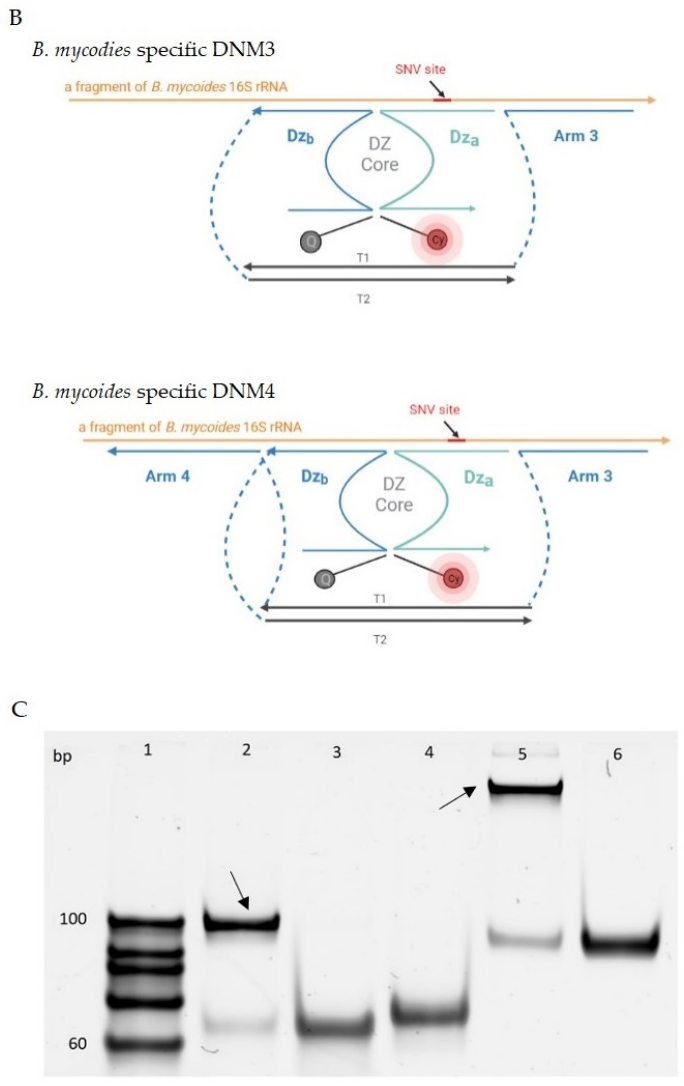
Figure 2. Design of DNM3 and DNM4 used in the study. ( A ) Design of B. thuringiensis –specific DNM3 and DNM4. DNM3 has a separate arm (Dz a ) and two arms (Dz a and Arm 3) attached to the dsDNA scaffold (T1 and T2). DNM4 has a separate arm (Dz a ) and three arms (Dz a , Arm 3 and Arm 4) attached to the dsDNA scaffold. Arms 3 and 4 were designed to tightly bind 16S rRNA, thereby unfolding its secondary structure. DNM3 and 4 cleaved F-sub, producing fluorescent output at 525 nm. ( B ) Design of B. mycoides –specific DNM3 and DNM4 was accomplished similar to that of DNMs for B. thuringiensis , but it cleaved Cy-Sub, producing fluorescent output at 617 nm. ( C ) Analysis of DNMs’ associations in PAGE gel: 1—Ladder; 2—DNM3 (T1, T2 strands annealed); 3—Tile strand T1; 4—T2 strand; 5—DNM4 (T1, T2 ′ stands annealed); 6—Tile T2 ′ strand (see Table S1 for sequences). The correct assembly of DNM3 and DNM4 are indicated by the arrows.